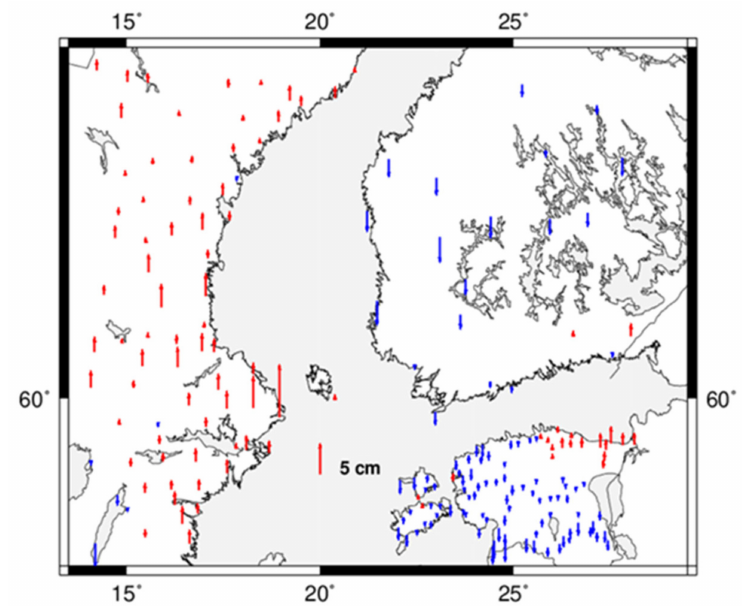
Figure 13. GNSS/levelling residuals from the 1-parameter fit of the final quasi-geoid model without corrections for specific country offsets (only one shift parameter estimated). Red arrows mean positive residuals, while blue means negative. The scale is given by the red arrow in the middle of the Baltic